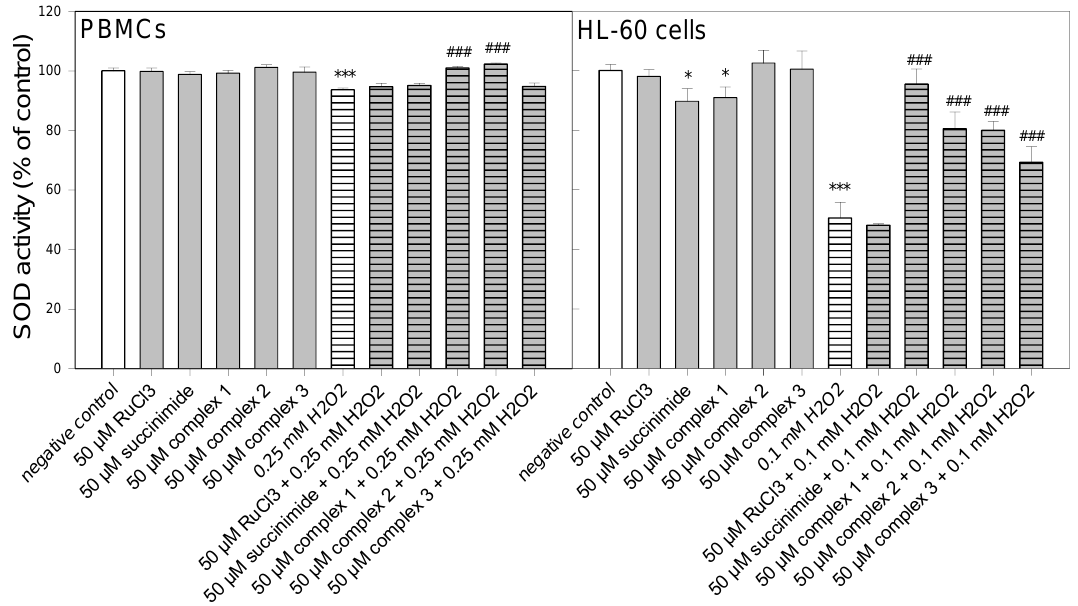
Figure 5. Superoxide dismutase activity in PBMCs and HL-60 cells pre-incubated for 24 h at 37 ◦ C with ruthenium complexes 1 – 3 at 50 µM and then incubated with H 2 O 2 at 0.25 mM in the case of PBMCs and 0.1 mM in the case of HL-60 cells. The figure shows the mean results ± SD, n = 3; * p < 0.05, and *** p < 0.001 vs. negative control; ### p < 0.001 vs. H 2 O 2 . Data were normalized to the negative control, which was assigned as 100% of the SOD activity.